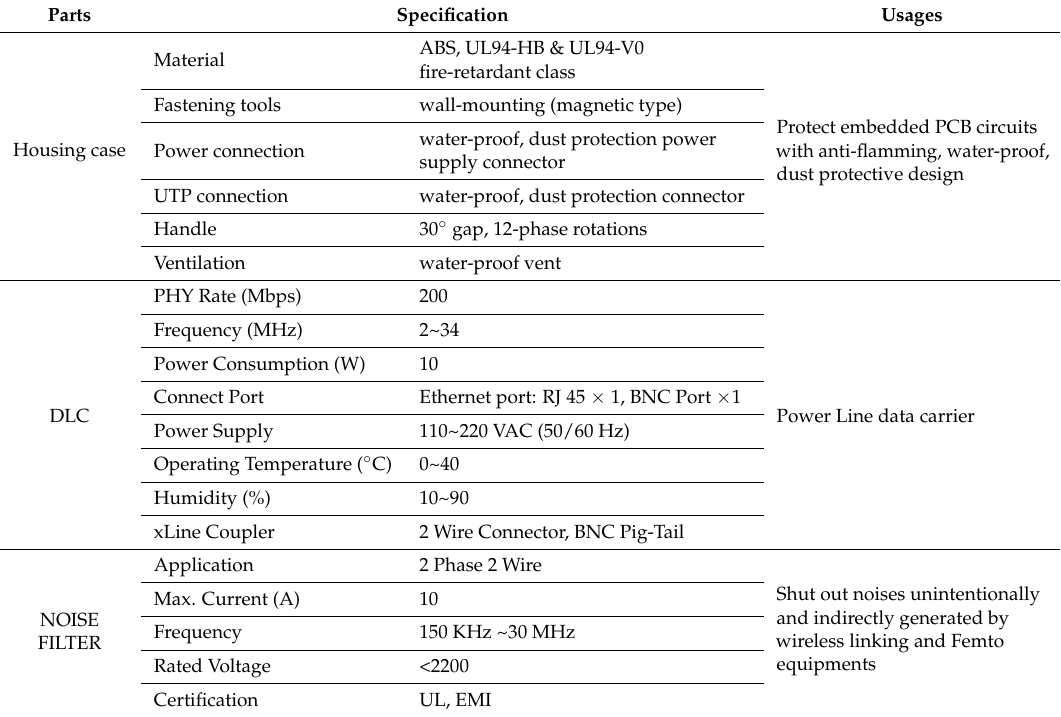
Table 3. Specifications of the DLF product.